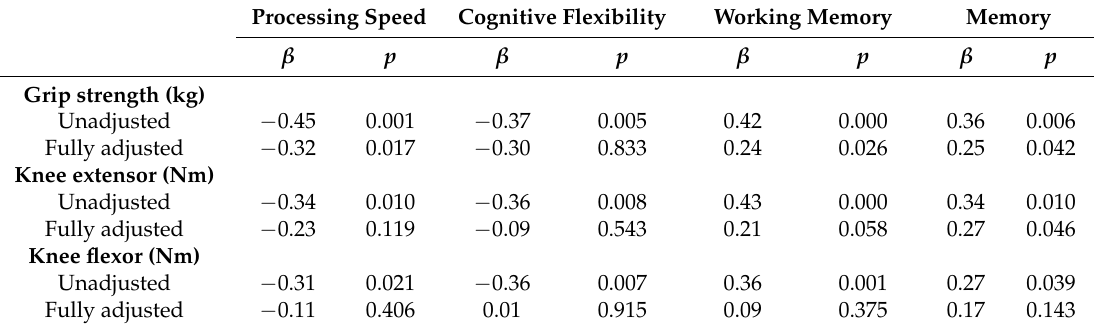
Table 3. Association between grip strength and leg strength with measures of cognitive function. (fully adjusted).